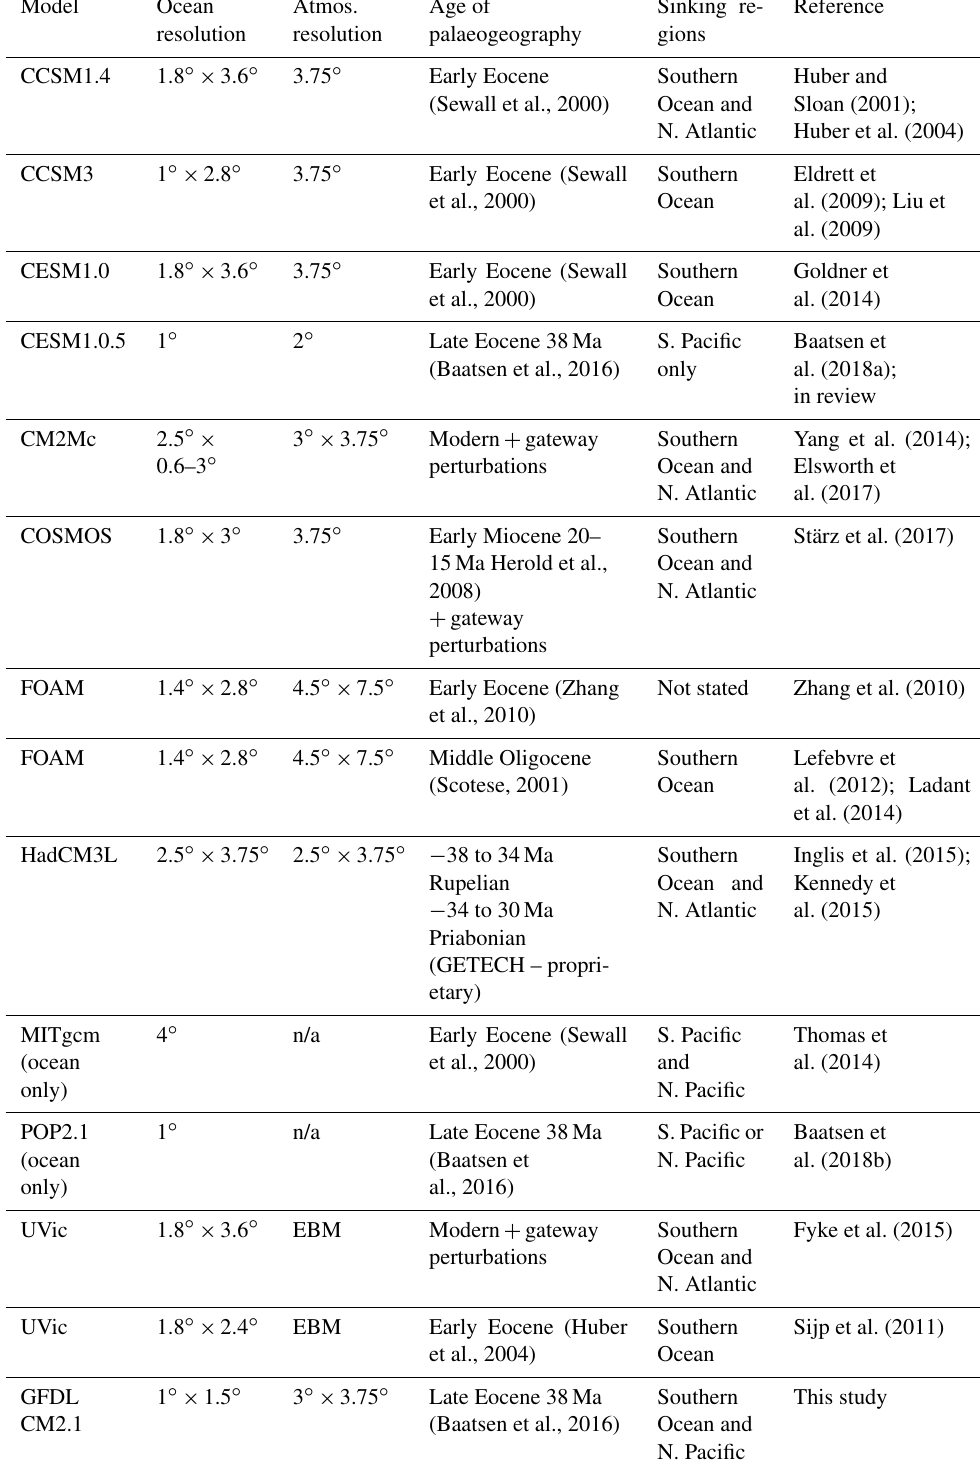
Table 1. A non-exhaustive summary of previous EOT climate simulations, including their ocean and atmosphere horizontal resolutions, age of palaeogeography and sinking regions. EBM represents a 2-D energy balance model. All are coupled climate models except the MITgcm (Thomas et al., 2014) and POP2.1 (Baatsen et al., 2018b) simulations, which are included because they specifically investigate the meridional overturning circulation (MOC) around the EOT. n/a means “not